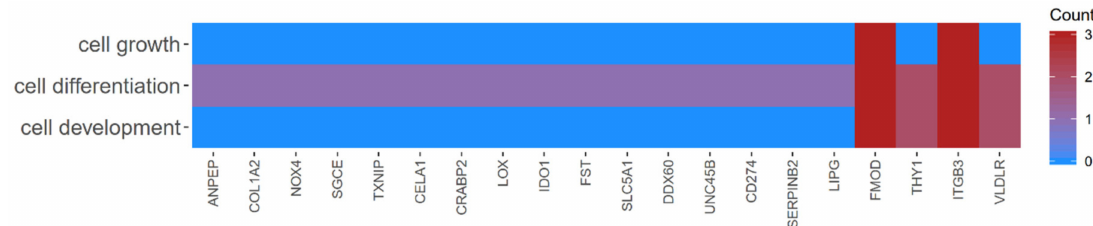
Figure 5. Heatmap showing the gene occurrence between 10 most upregulated and 10 most downregulated genes that belongs to the “cell differentiation”, “cell growth”, “cell maturation” and “cell development” GO BP terms as well as “signaling pathways regulating pluripotency of stem cells” KEGG pathway. The red color is associated with gene occurrence in the GO Term. The intensity of the color is corresponding to amount of GO BP terms that each gene belongs to.